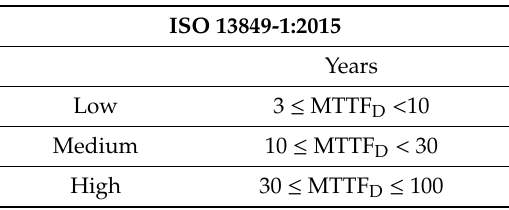
Table 13. Mean time to dangerous failure of each